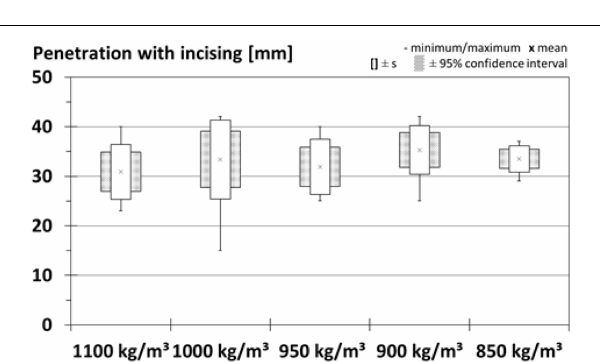
FIGURE 8 | Penetration depth of an alternative oily preservative in mm in specimens without incising.